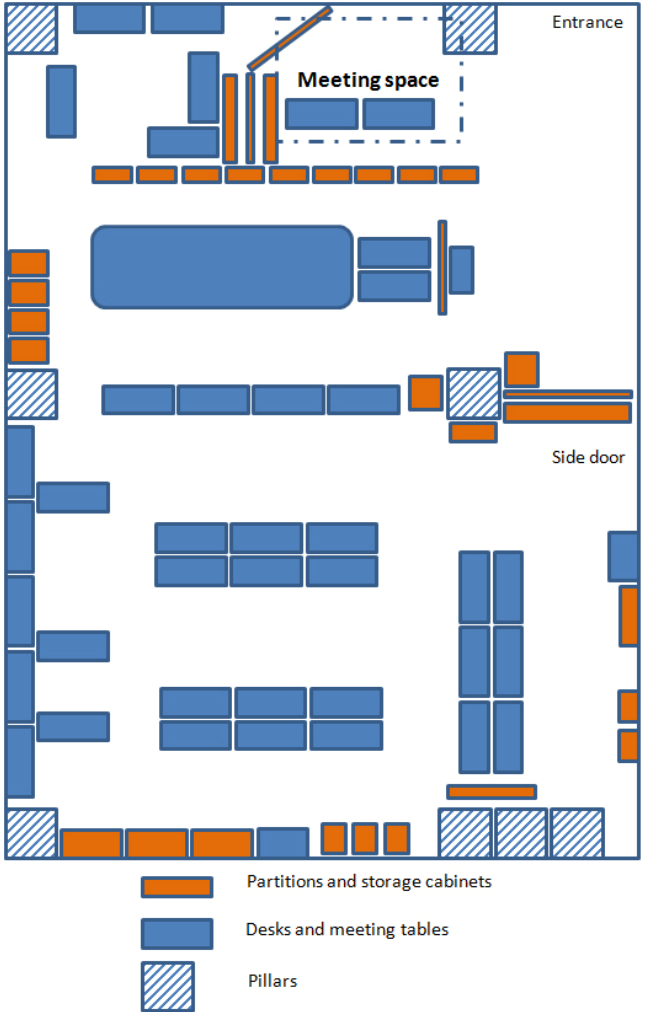
Figure 1. Office layout before the